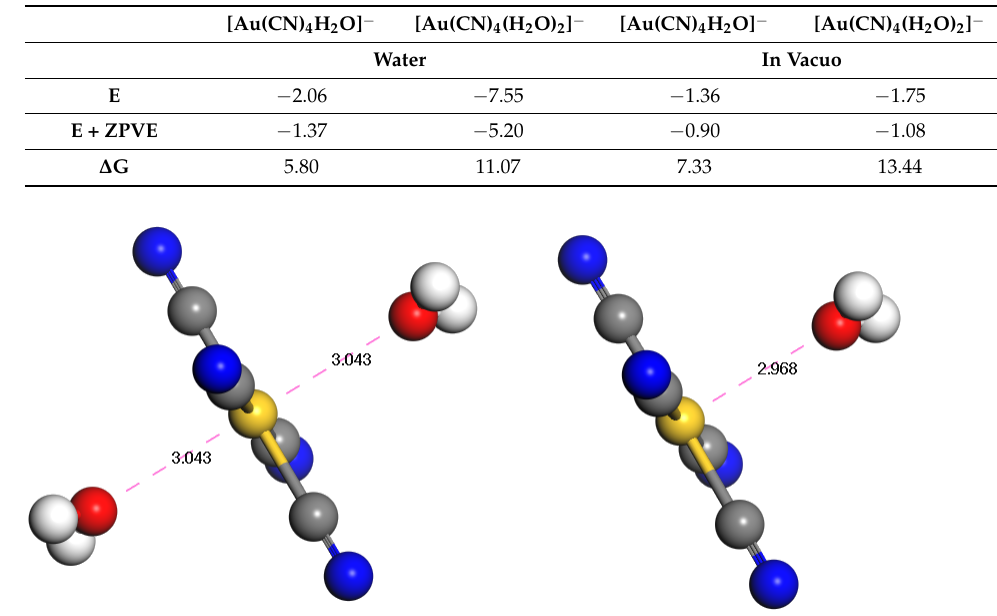
Figure 7. The structures of the gold(III) tetracyanide aquo ( right ) and diaquo ( left ) complexes, [Au(CN) 4 H 2 O] − and [Au(CN) 4 (H 2 O) 2 ] − . Atom coloring: Au—gold, C—grey, N—blue, O—red, and H—white. Despite the intermolecular electrostatic interactions occurring between the positively charged Au atom of Au(CN) 4 − and oxygen atoms of water, the decrease of entropy destabilizes those aquo complexes.